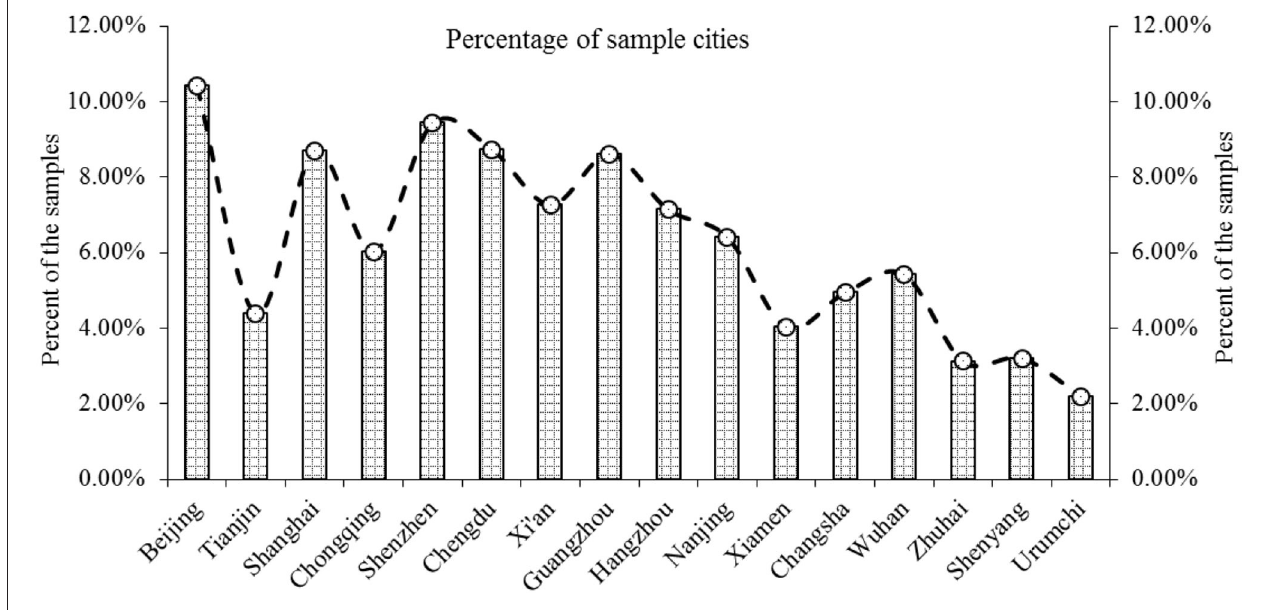
FIGURE 3 | Questionnaires percentage of sample cities.